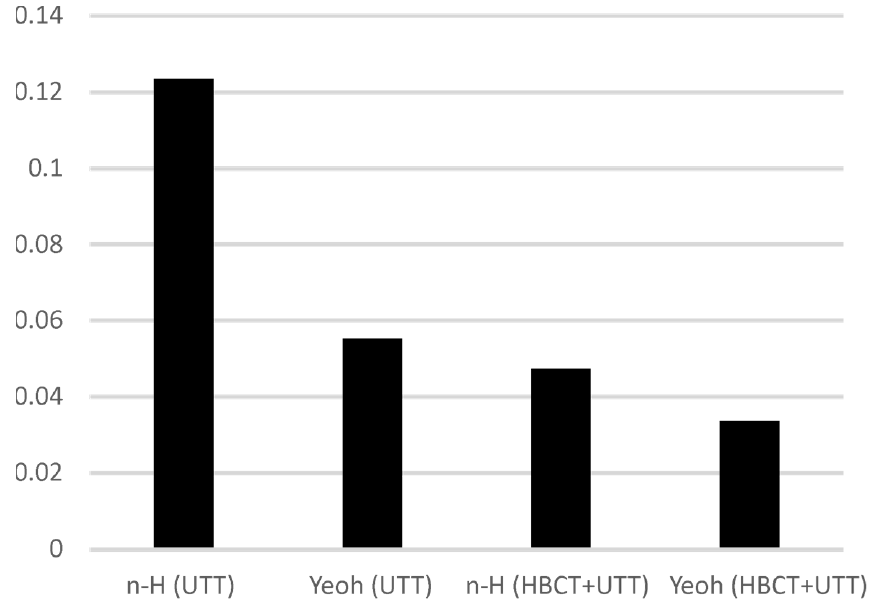
Figure 10. Normalized mean squared error for low bearing compression test with successive sets of material parameters.